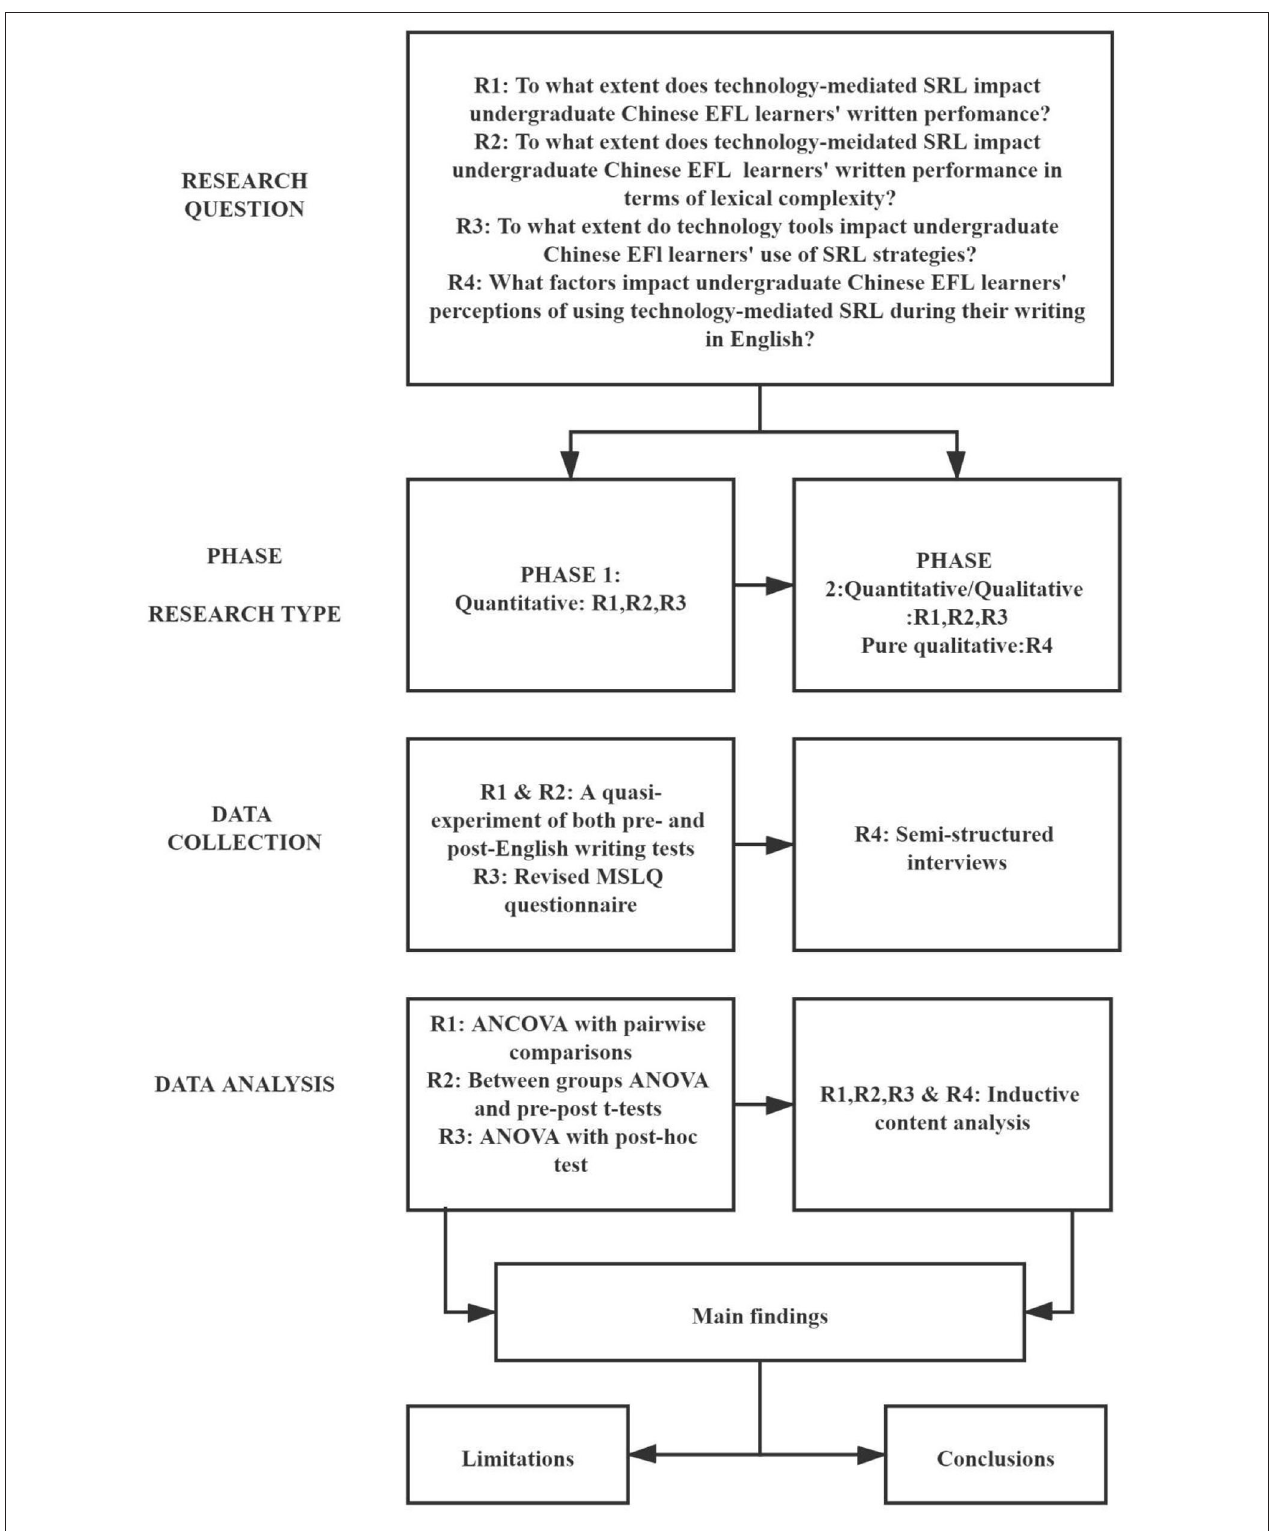
FIGURE 6 | Flowchart-research